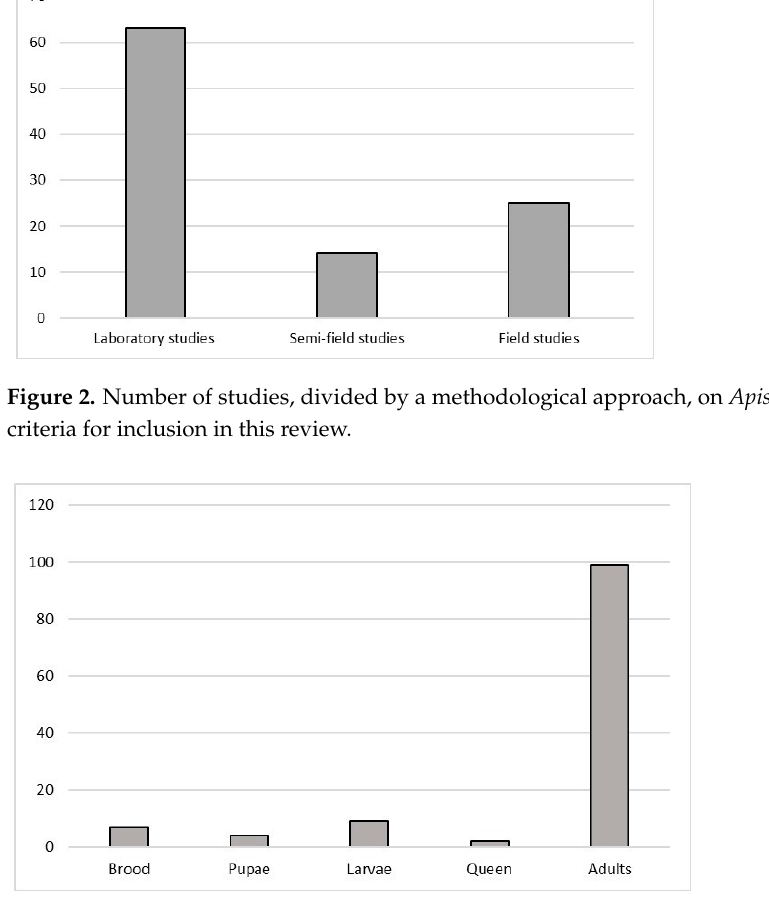
Figure 3. Number of studies, divided by life stages, on Apis mellifera , that met the criteria for inclu- sion in this review.